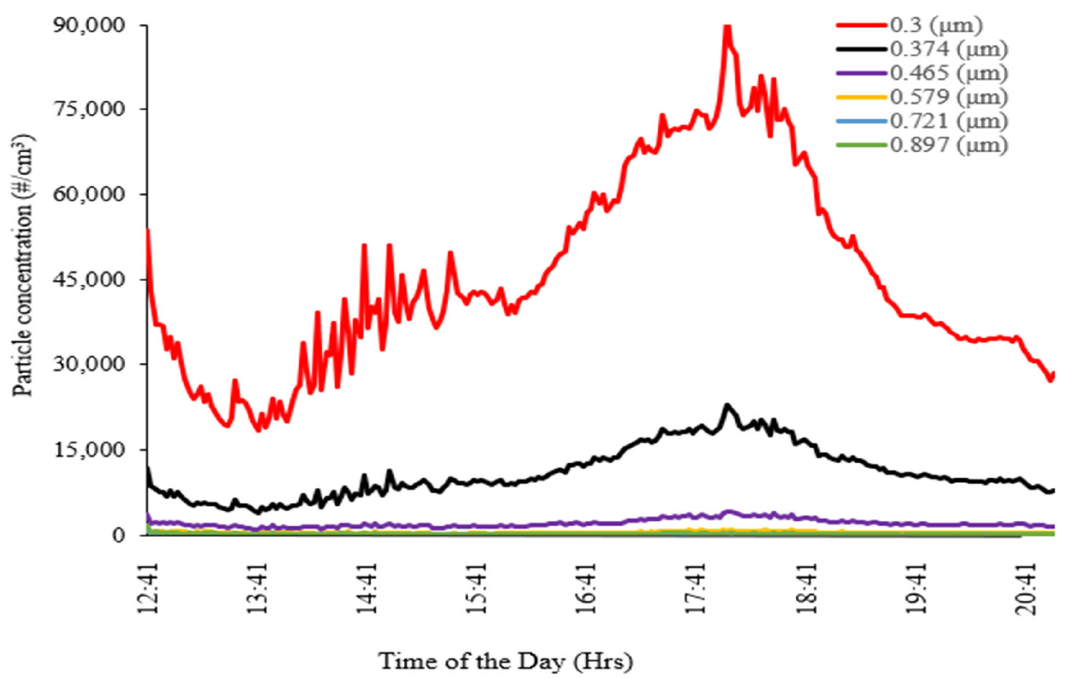
Figure 5. Size segregated sub ‐ micron PM particle number variations at the Port of Albany on 13 November 2018.